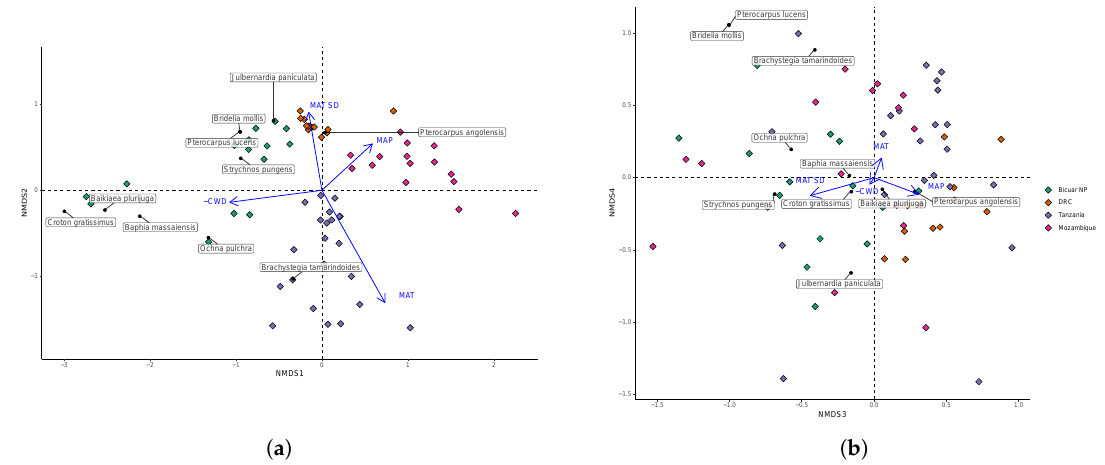
Figure 4. Environmental factors fitted to axes 1 and 2 ( a ), 3 and 4 ( b ) of the NMDS ordination of species composition of one hectare plots, showing the variation in plot species composition within and among sites. Diamonds are plot scores coloured by site. The lengths of arrows indicating environmental factor fits are scaled by R 2 . Arrows point in the direction of increasing values of that environmental factor. Please note that Climatic Water Deficit (CWD) is expressed more intuitively as the negative inverse of CWD, thus larger values indicate higher levels of